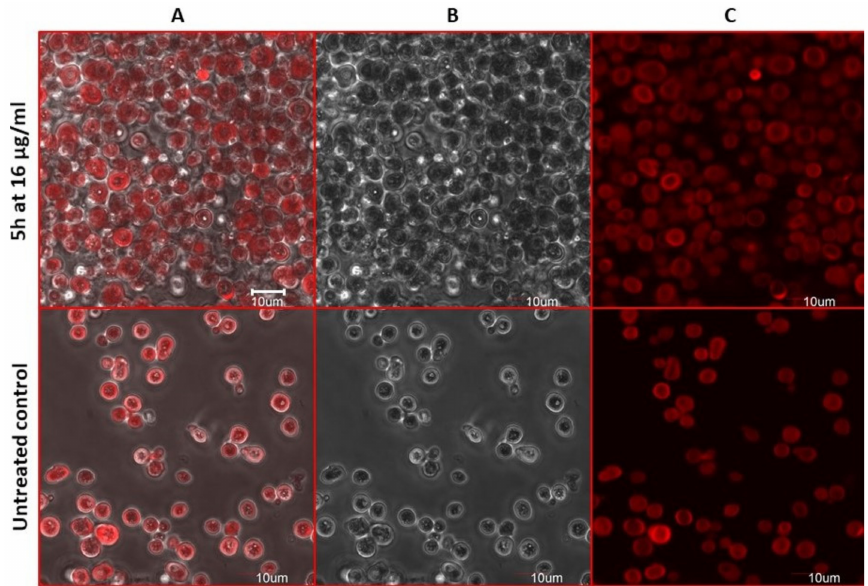
Figure 8. The C. neoformans SPZ173 sessile growth stained with Congo red (CR). Legend: Confocal laser scanning microscope (CLSM) analyses: ( A ) phase contrast and fluorescence merged; ( B ) phase contrast and ( C ) fluorescence images. ( A – C ) Upper raw depicts beta -glucan CR-stained in the conglomerate of sessile cells treated with 5h at 16 µ g/mL. Lower raw included the untreated controls showing CR staining.